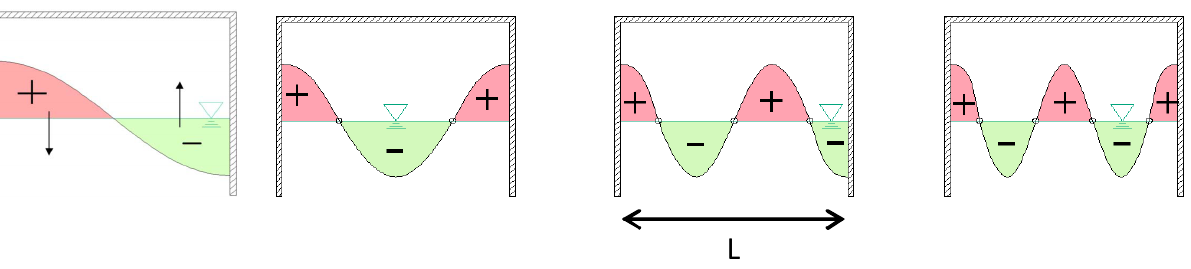
Figure 9. Free oscillations inside the